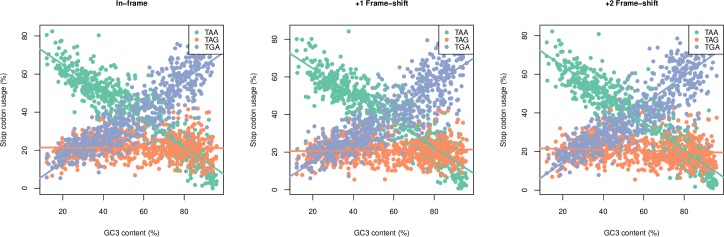
Relative usage of each stop codon in 3’ UTRs plotted against GC3 content for TT11 bacterial species.Surprisingly, we find that trends in the decoupled TGA and TAG to be consistent across all three reading frames. Spearman’s rank correlation information can be found in S5 Table.